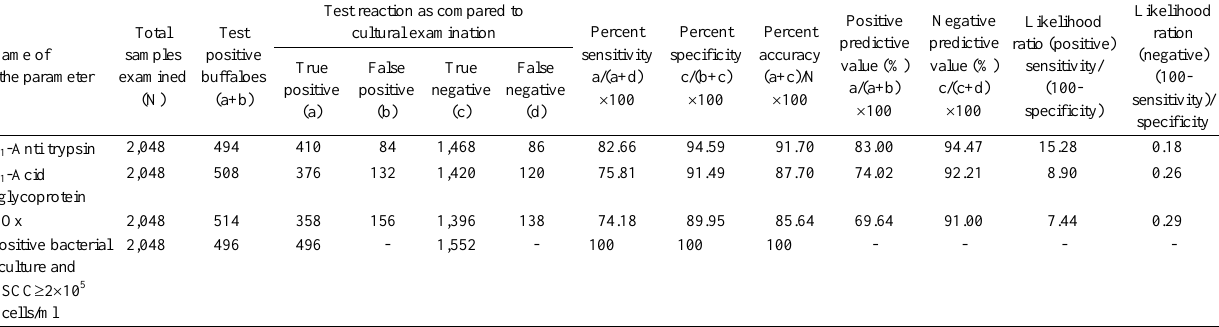
Table 4. Evaluation of  1 -anti trypsin,  1 -acid glycoprotein and NOx as an indicator for diagnosis of subclinical mastitis in riverine buffalo